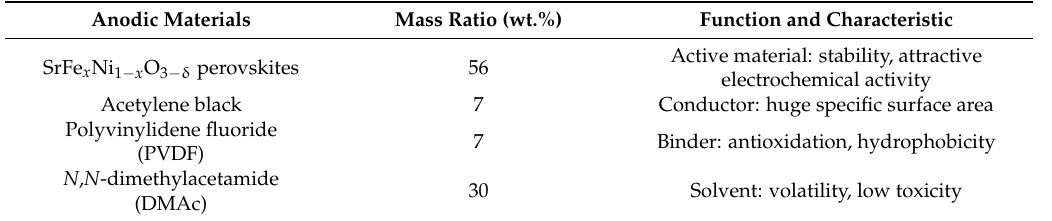
Figure 2. Schematic diagram of the preparation of the SrFe x Ni 1− x O 3−δ /Ti anode. ( N , N -dimethylacetamide, DMAc; Polyvinylidene fluoride, PVDF) Table 1. Components of materials for preparing the SrFe x Ni 1 − x O 3 − δ /Ti anode. Anodic Materials Mass Ratio